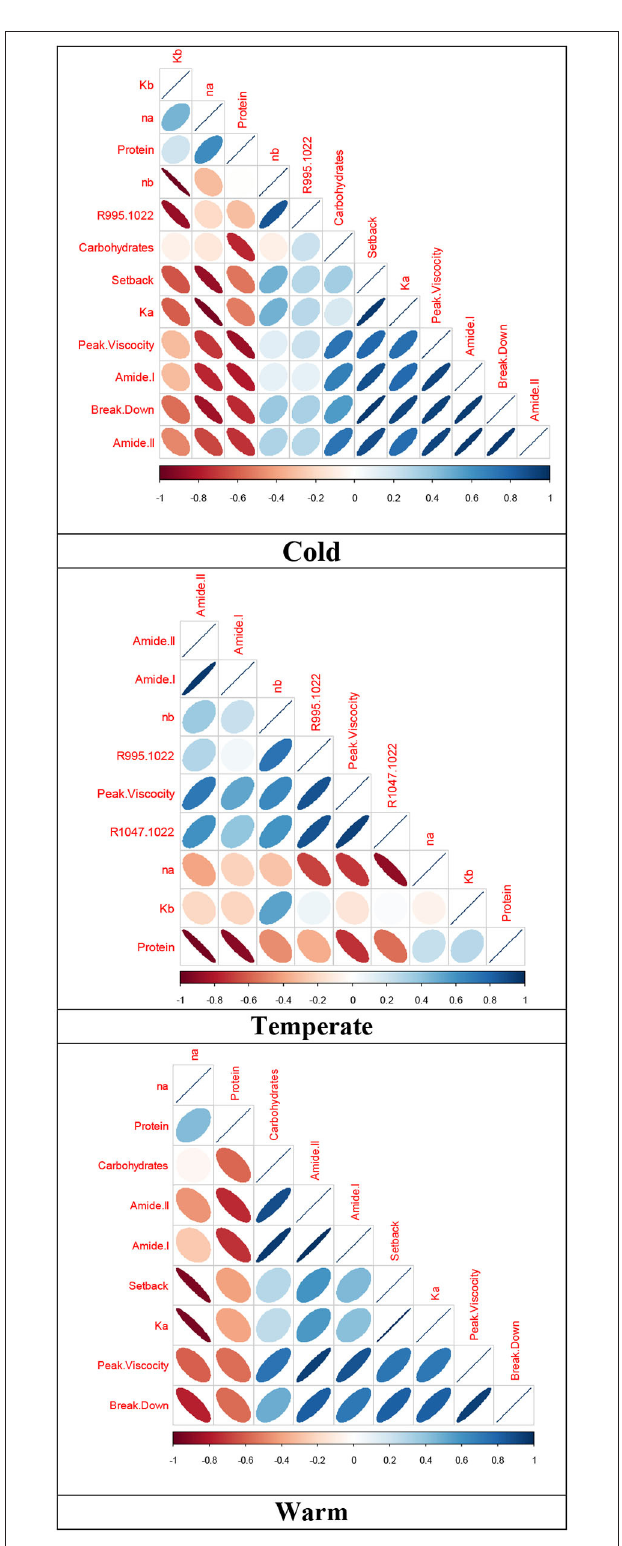
FIGURE 2 | Spearman’s correlation for structural and rheological attributes of quinoa grains harvested at different altitudinal gradients. Red cells indicate negative correlations, and blue cells show positive